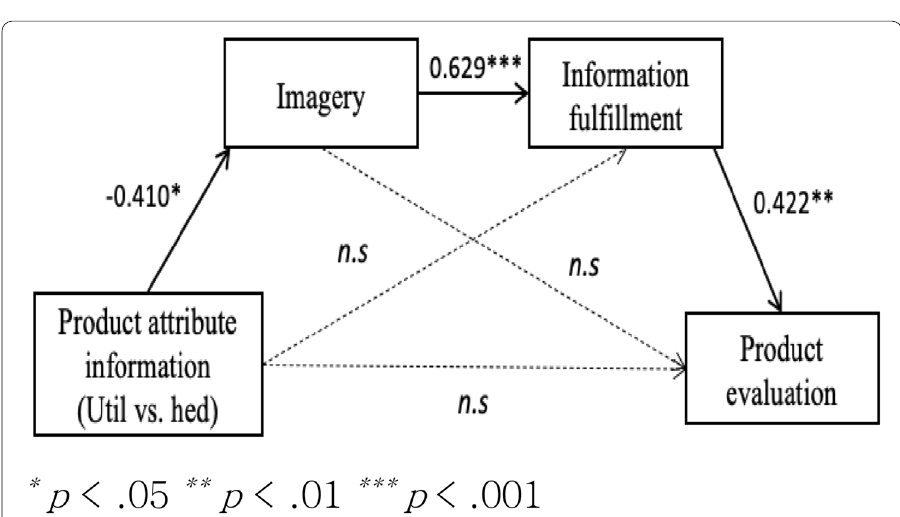
Fig. 5 Sequential mediation of imagery and information fulfillment in the effect of product attribute information on product